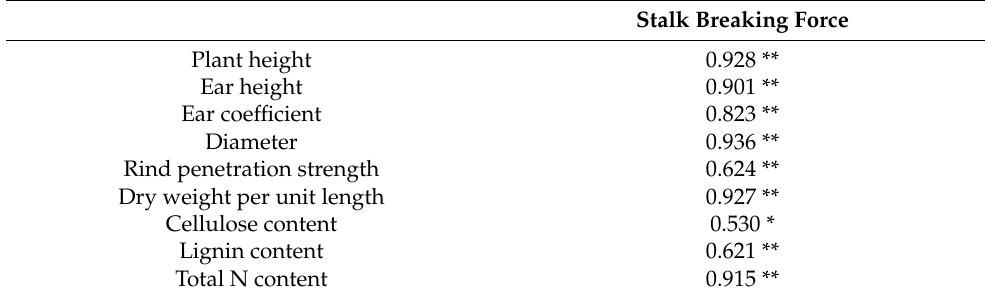
Figure 5. Effect of fertilization methods on N content of the third elongation internode at harvest stage under different nitrogen application rates. N150, N250, and N350 refer to the nitrogen application rate being 150, 250, and 350 kg ha − 1 , respectively. “z” refers to the nitrogen application rate being zero, “f” refers to the nitrogen application rate being 150 kg ha − 1 , “t” refers to the nitrogen application rate being 100 kg ha − 1 , e.g., Nf refers to nitrogen application rate being 150 kg ha − 1 at sowing stage; Nfzt refers to nitrogen application rate being 150, 0, and 100 kg ha − 1 at sowing, 6-leaf, and 12-leaf stages, respectively; Nzftt refers to the nitrogen application rate being 0, 150, 100, and 100 kg ha − 1 at sowing, 6-leaf, 12-leaf, and silking stages, respectively. Capital letters indicate a significant difference at the p < 0.05 level under different nitrogen application rates. Lowercase letters indicate a significant difference at the p < 0.05 under all treatments. Table 4. Correlation analysis between stalk breaking force and plant morphology, stalk mechanical strength, and material content at harvest.